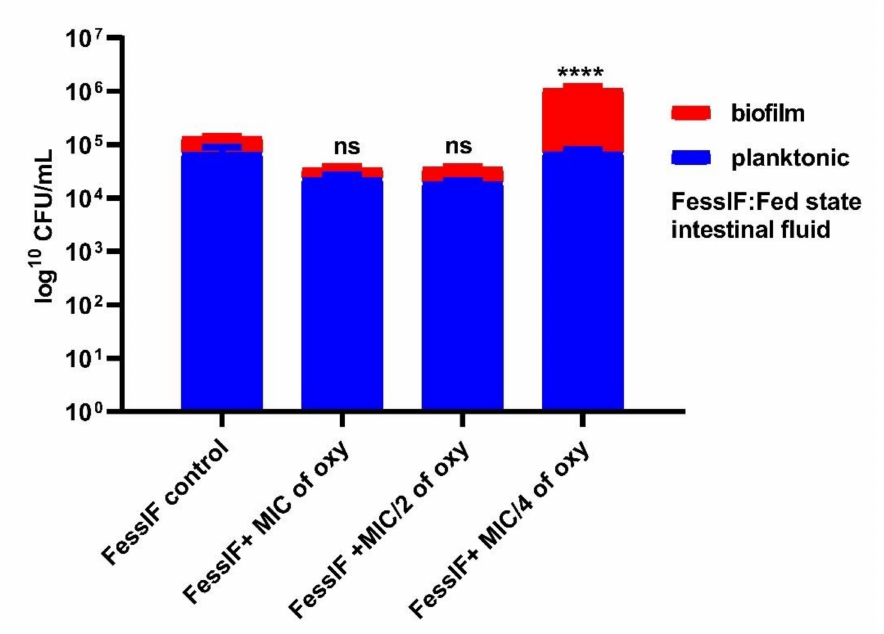
Figure 11. Viable counts (log CFU/mL) of L. fermentum ASBT-2 after 3 h of exposure to fed state